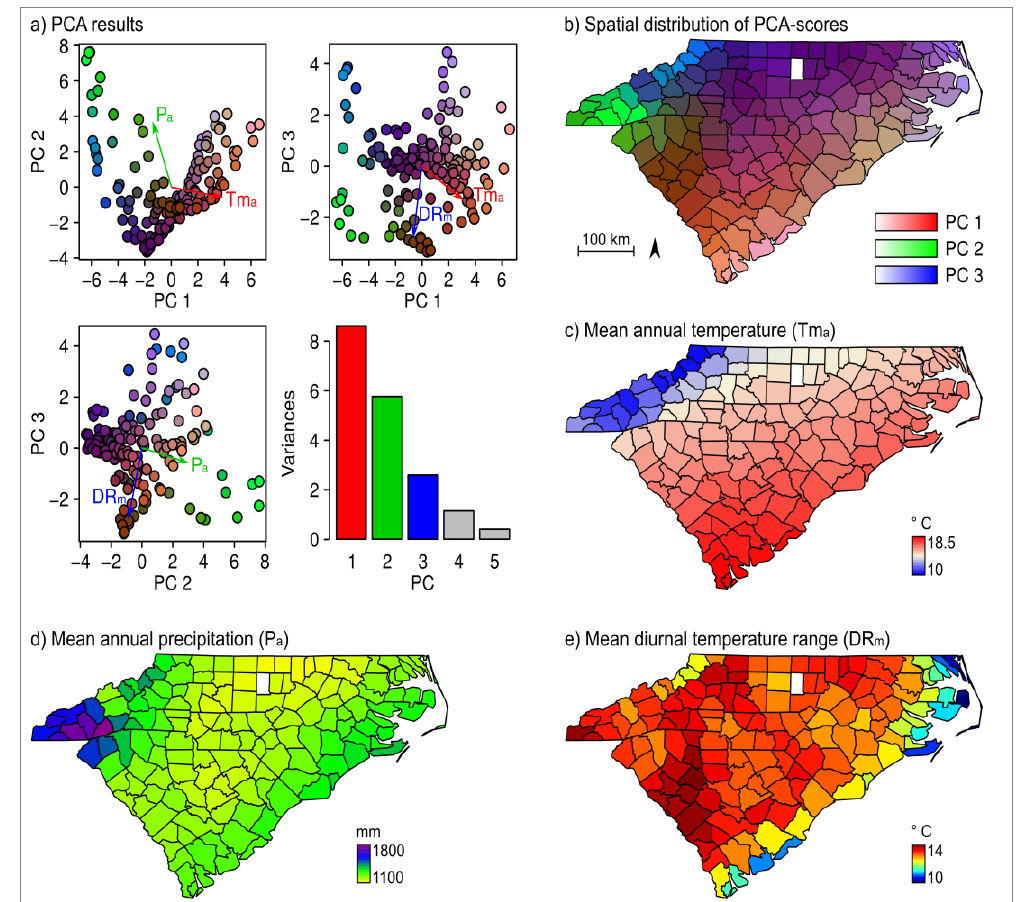
Figure 4. Results of the PCA of the bioclimate data ( a ), spatial distribution of the PC-scores ( b ), and spatial distribution of mean annual temperature ( c ), mean annual precipitation ( d ), and mean diurnal temperature range ( e